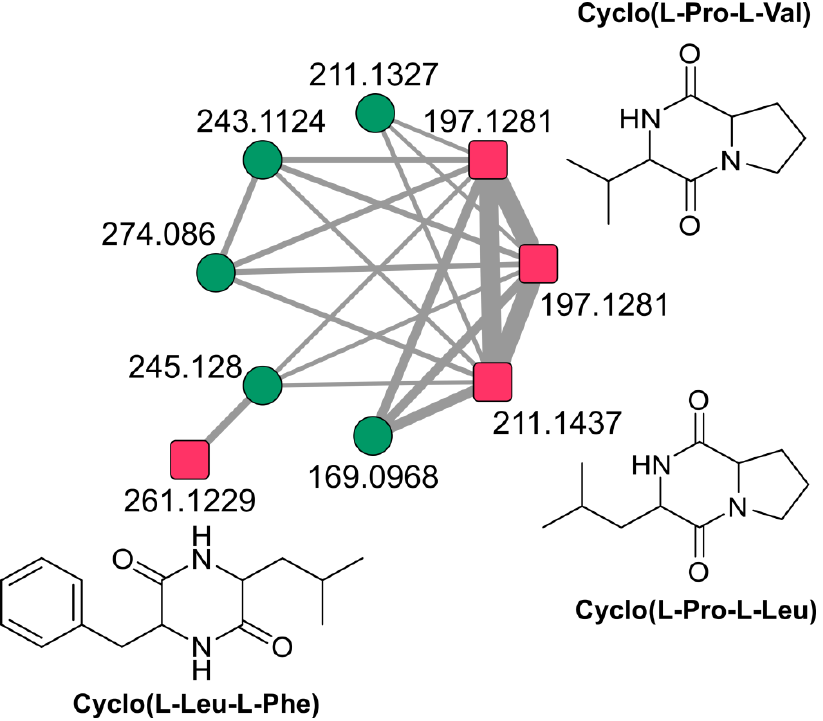
Figure 4. 2, 5-diketopiperazines cluster in S. tendae VITAKN molecular network. Each node represents m / z value of the parent ion and edge thickness signifies cosine score similarity.